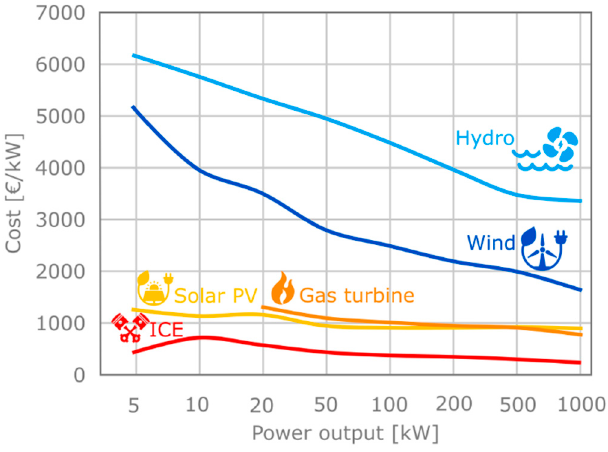
Figure 26. Investment cost as a function of installed capacity for different power generation tech- Figure 26. nologies [68]